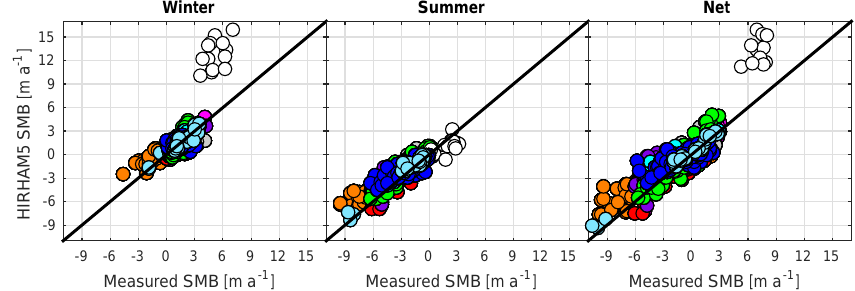
Figure 8. Comparison of SMB measurements from Vatnajökull ice cap from 1995 to 2014 and HIRHAM5 simulated values. Different colours represent different outlet glaciers; see Fig. 1b. The white dots are from a point on